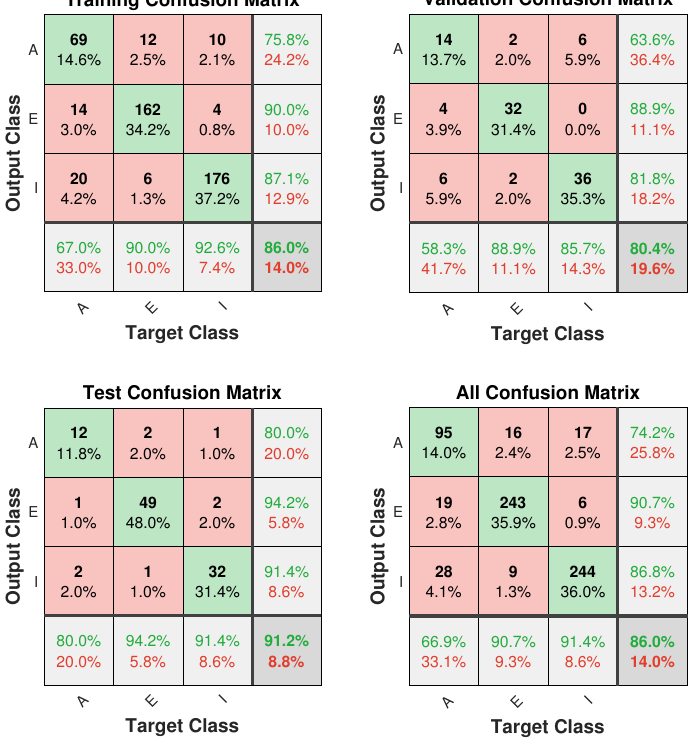
Figure 6. ANN algorithm based simulation results for the classification of train traffic flows AEI framework mobility predictions using three classes; Access (A), Egress (E), and Interchange